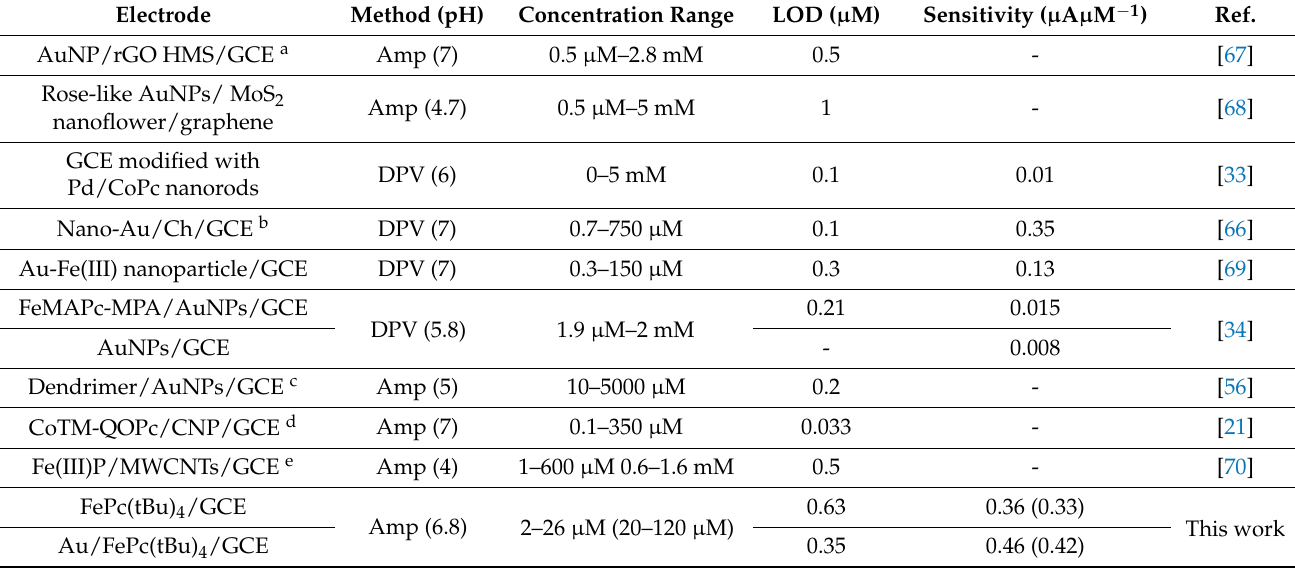
Table 3. Comparison of the analytical performance of the FePc(tBu) 4 /GCE and Au/FePc(tBu) 4 /GCE with other nitrite